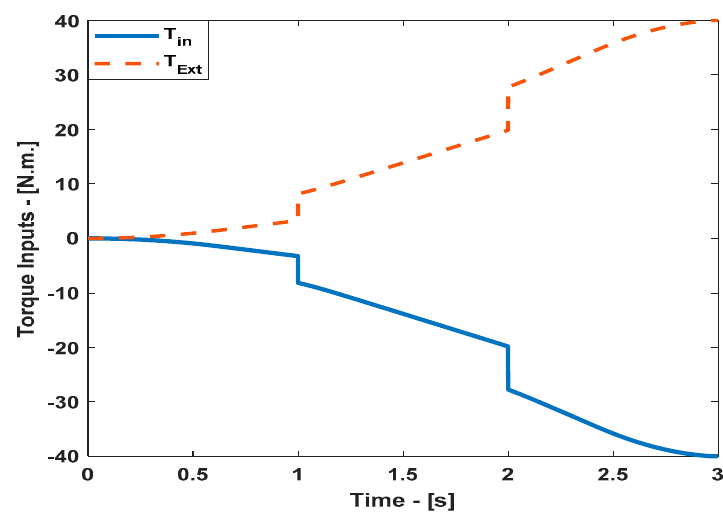
Figure 10. The responses of the BcVSA based on the CTC scheme in the scenario of altering the status of clutches while the system is running. ( Top ) the input trajectory response; ( Bottom ) the output re- sponse.